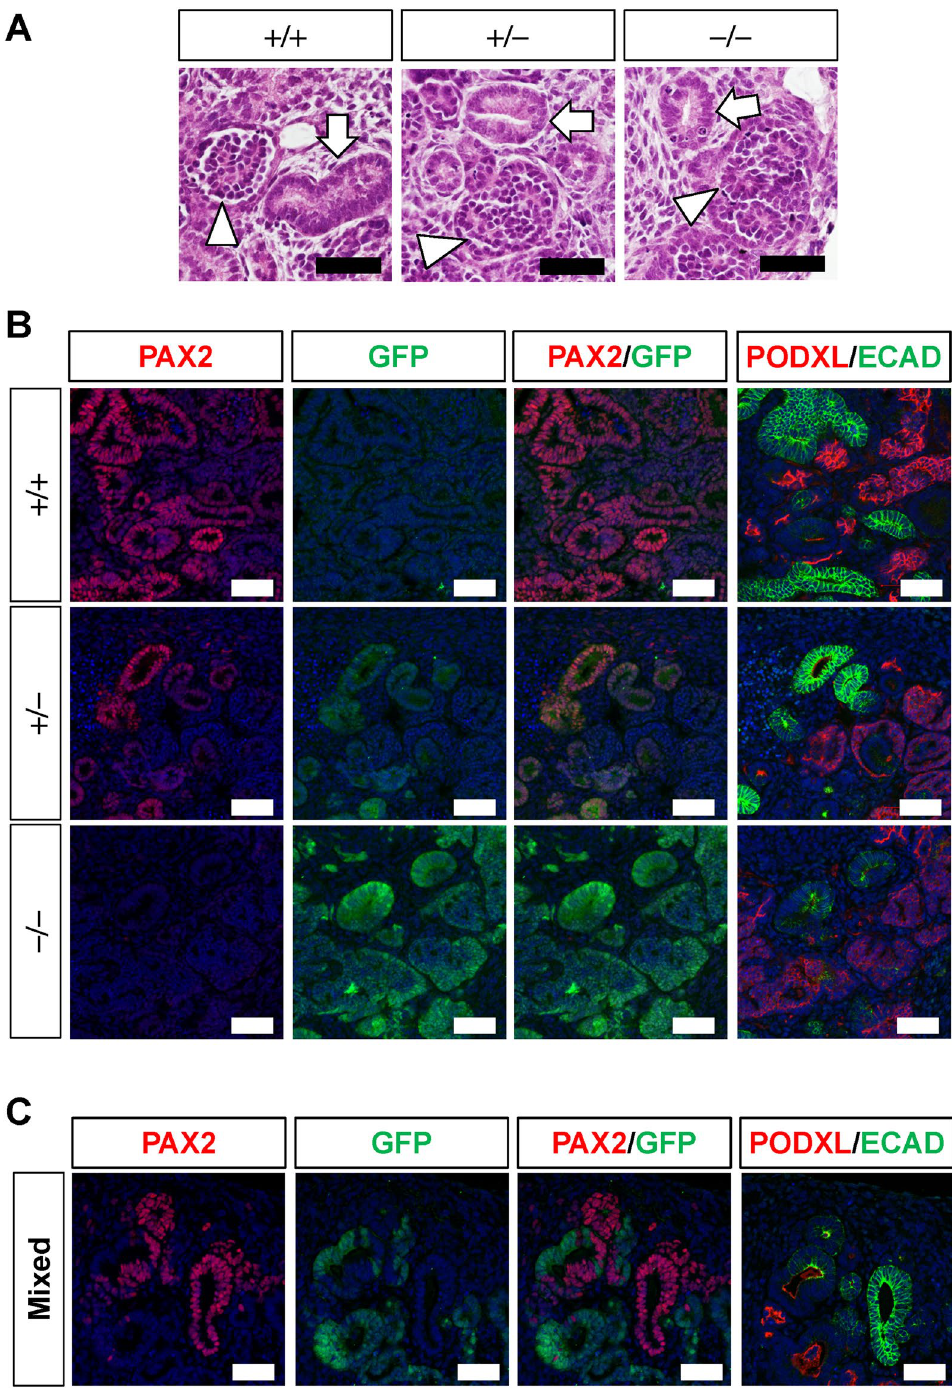
Figure 2. Successful deletion of PAX2 in renal tubules derived from iPS cells. ( A ) Hematoxylin–eosin (HE) staining of kidney tissues induced from wild-type ( + / + ), heterozygous ( + / − ), and homozygous ( − / − ) clones. Arrowheads: glomeruli; arrows: renal tubules. ( B ) PAX2 (red) and GFP (green) staining of kidney tissues induced from the three genotypes. Rightmost columns: neighbouring sections were stained with markers for renal tubules (E-cadherin: ECAD) and glomerular podocytes (podocalyxin: PODXL). ( C ) Nephron formation from a mixed colony of iPS cells. Nephron epithelia are composed of PAX2 + wild-type and GFP + mutant cells. Scale bars: 50 µ